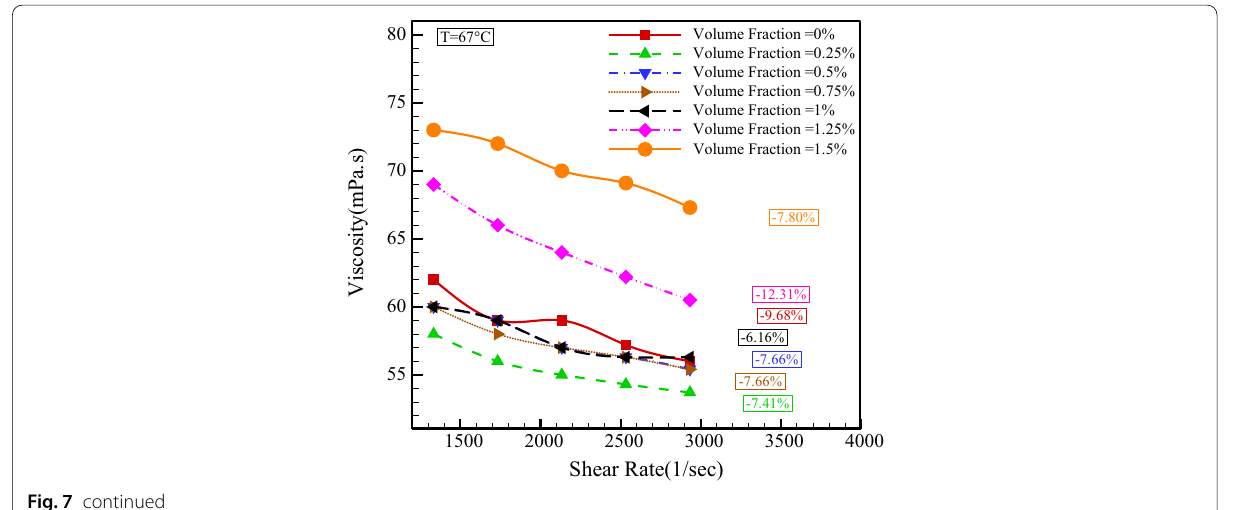
Nanofluid Behavior Variations of shear tension with SR for different NPS- VFs and temperatures are shown in Fig. 4. As expected, τ = m ˙ γ n